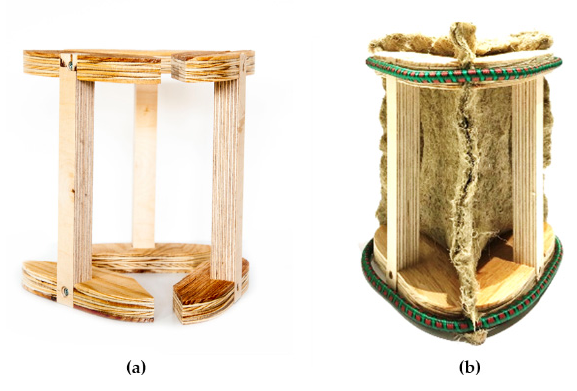
Figure 5. ( a ) Wooden framework, ( b ) hemp mat.